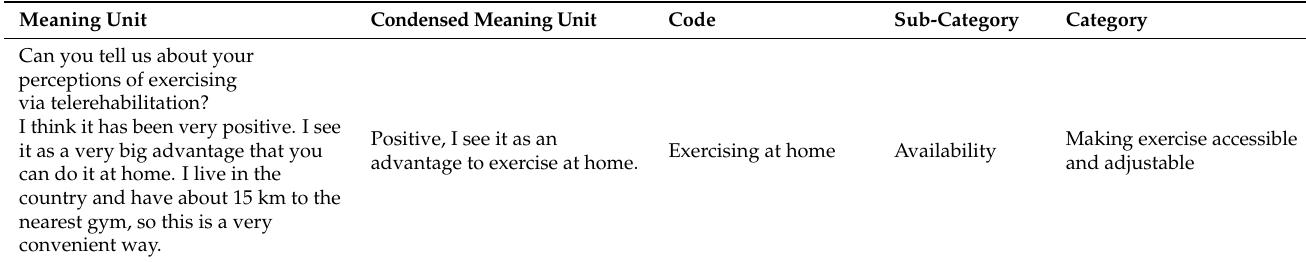
Table 1. Example of the data analysis process.